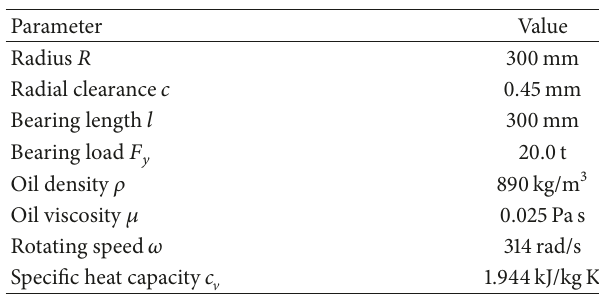
Table 1: Bearing